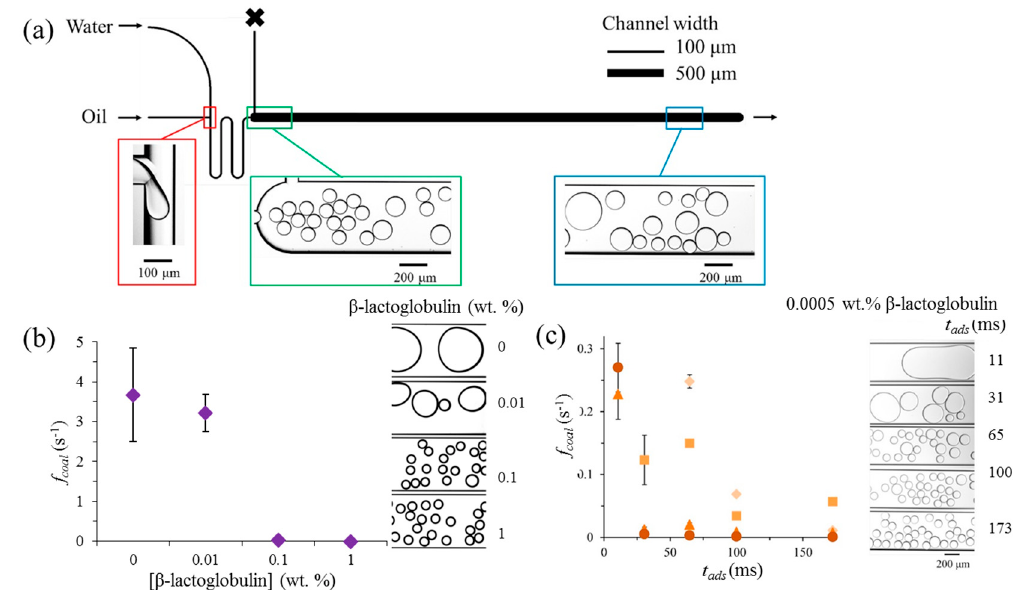
Figure 9. ( a ) Coalescence chamber, including a T-junction (red rectangle), a meandering adsorption channel, and a coalescence channel; reprinted from Muijlwijk et al. (2017) [11], with permission from Elsevier. ( b ) The coalescence frequency of bubbles as a function of protein concentration, at 100 ms adsorption time; reproduced from Muijlwijk (2017) [72]. ( c ) The coalescence frequency of droplets as function of adsorption time (achieved by varying the length of the meandering channel) and wt. % β -lactoglobulin (0.005, 0.001, 0.05, and 0.01, darker symbols correspond to higher concentrations); reprinted from Muijlwijk et al. (2017) [11], with permission from Elsevier.